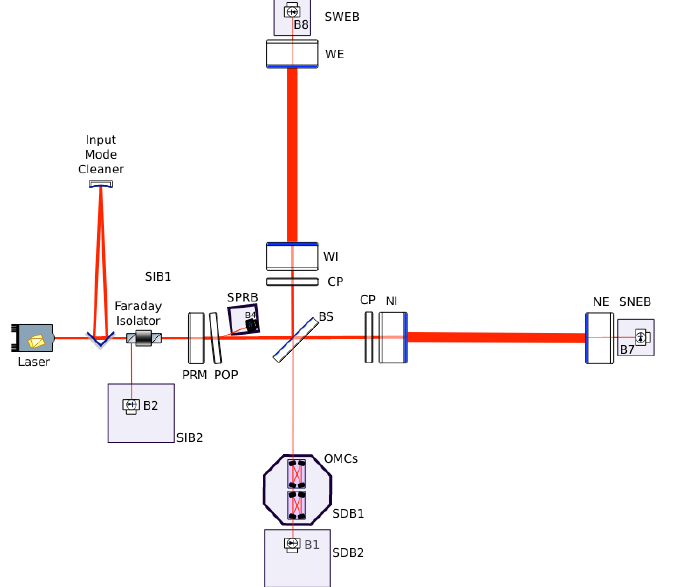
Figure 16. Layout of the Advanced Virgo interferometer [19]. The suspended benches are placed in transmission from the end